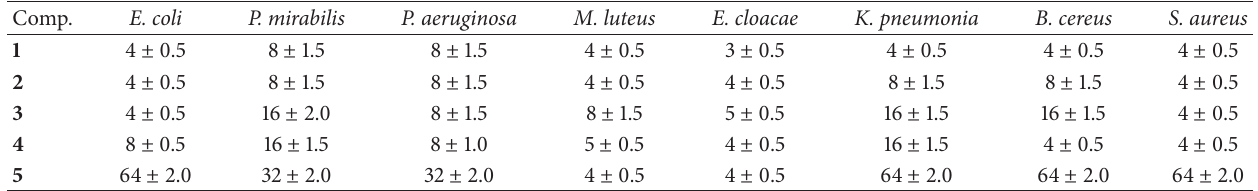
Table 3: MICs ( 𝜇 g/mL) of 1–5 isolated from C. sativum against bacterial strains.